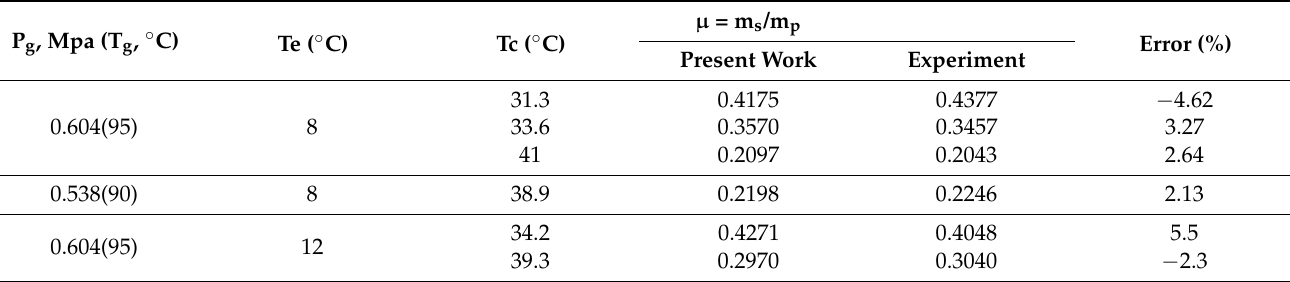
Table 7. Validation of ejector